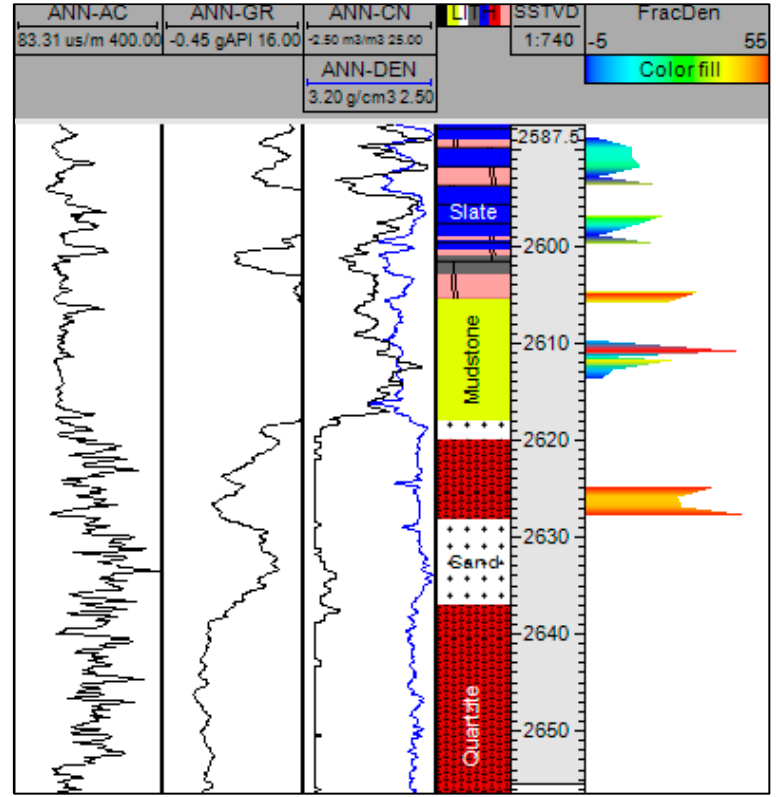
Figure 10. Comparison of wireline logs, lithology, and fracture density (m 2 /m 3 ) at well A-67.